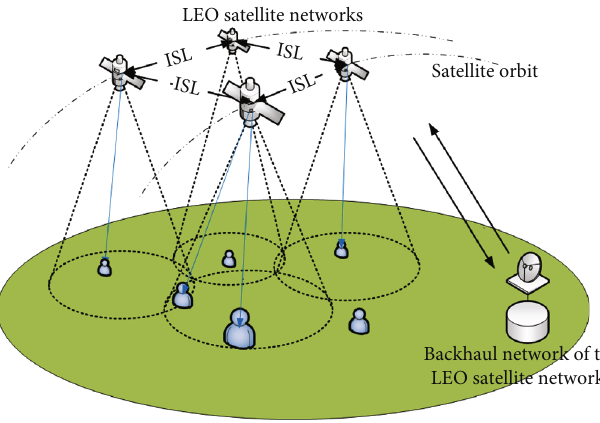
Figure 1: A LEO satellite network is composed of M LEO satellites and N ground